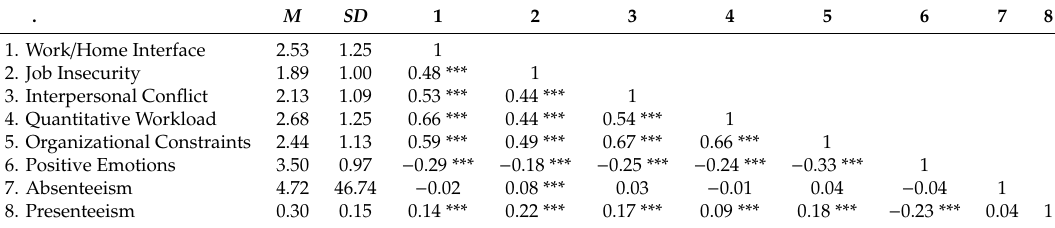
Table 2. Means, standard deviations, and correlations among the main variables.